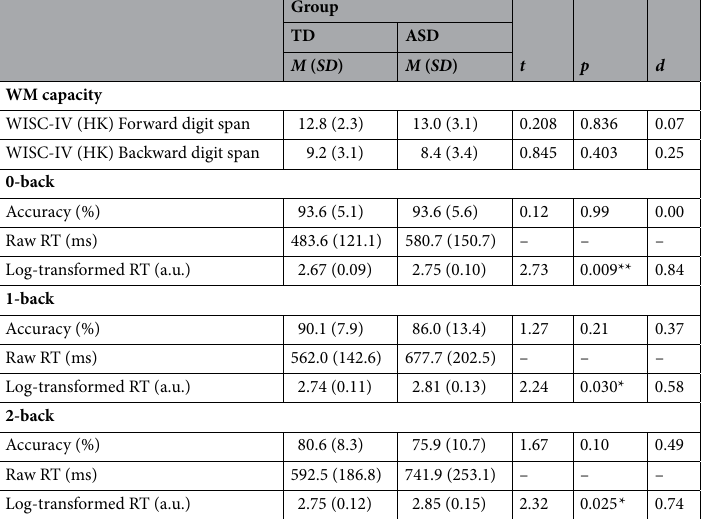
Behavioral performance. Table 2 presents the WISC-IV (HK) forward and backward digit span data,